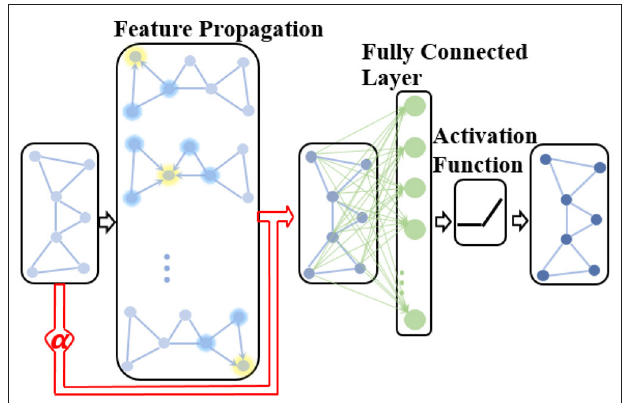
FIGURE 3 | The structure of the improved GCN with the adaptive native node attribute (ANNA) unit. The red section indicates the ANNA unit, which adaptively adjusts the contribution of native node features in the extracted network